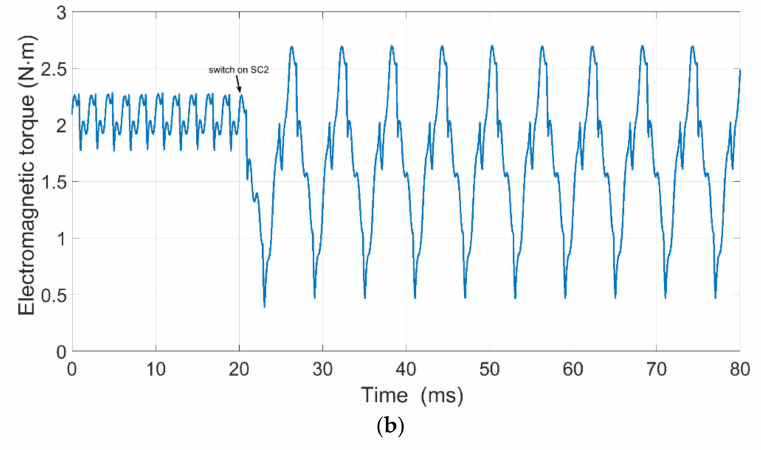
Figure 15. Y (cid:52) configuration—waveforms of electromagnetic torque ( a ) healthy to SC1, ( b ) healthy to SC2.